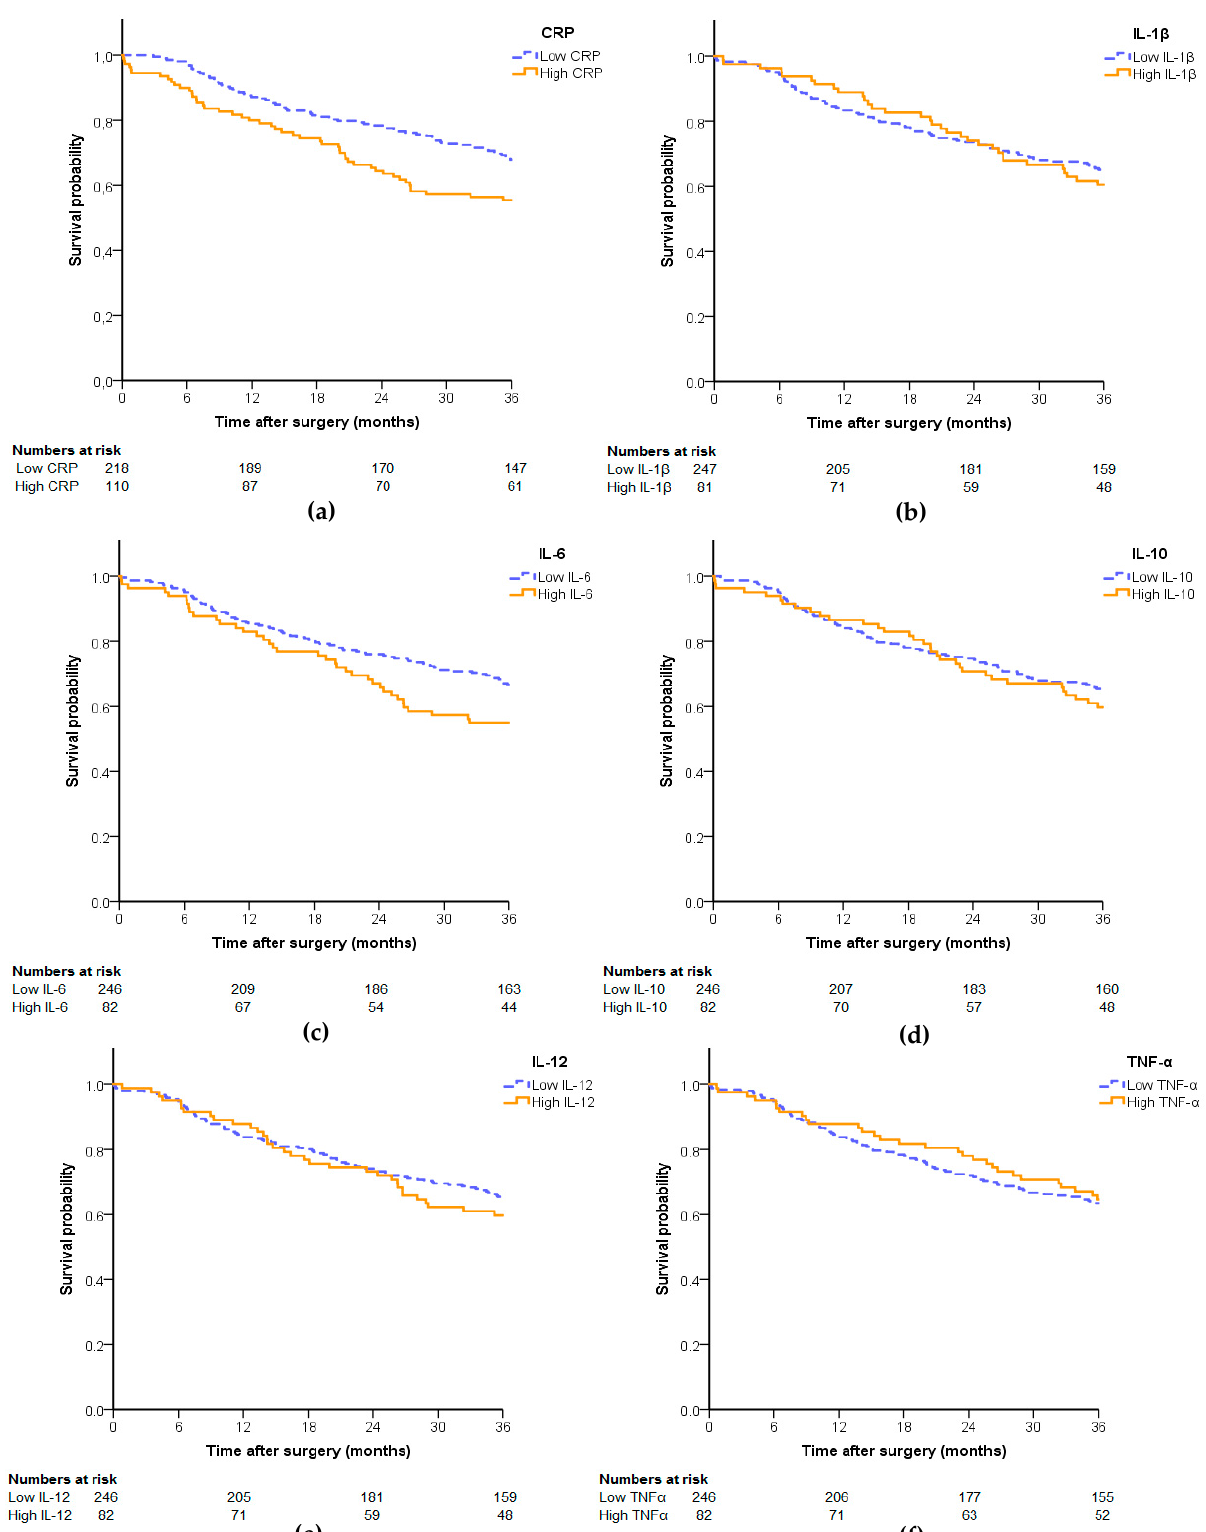
Figure 2. Kaplan–Meier curves displaying survival rates at 3 years after surgery among patients dichotomized as having high 1 or low 2 preoperative levels of the inflammatory markers: ( a ) CRP, ( b ) IL-1 β , ( c ) IL-6, ( d ) IL-10, ( e ) IL-12 and ( f ) TNF- α . 1 High is defined as being in the highest 25% of plasma levels for interleukins and TNF- α , and ≥ 10 mg/L for CRP. 2 Low is defined as being in the lowest 75% of plasma levels for interleukins and TNF- α , and <10 mg/L for CRP.